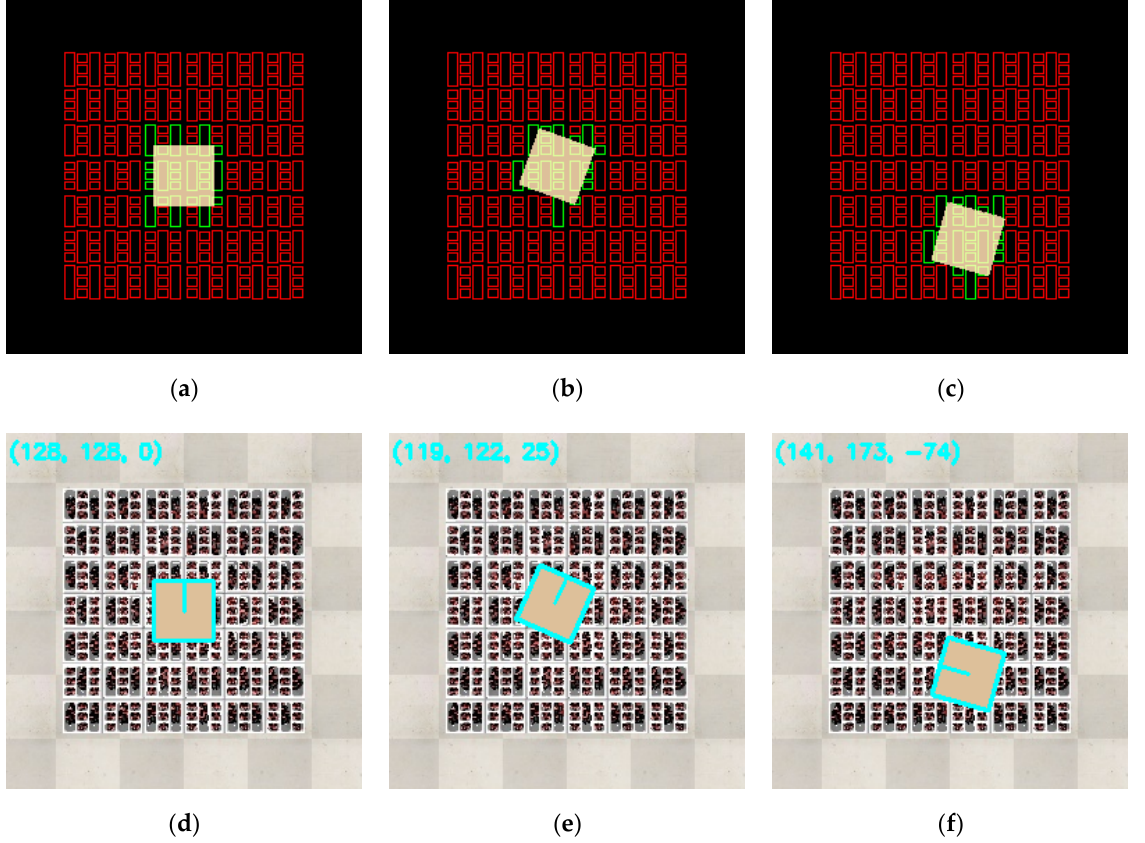
Figure 10. Images captured at time ( a , d ) k = 0 ms, ( b , e ) k = 660 ms, and ( c , f ) k = 8040 ms in one of the experiments conducted in this paper.